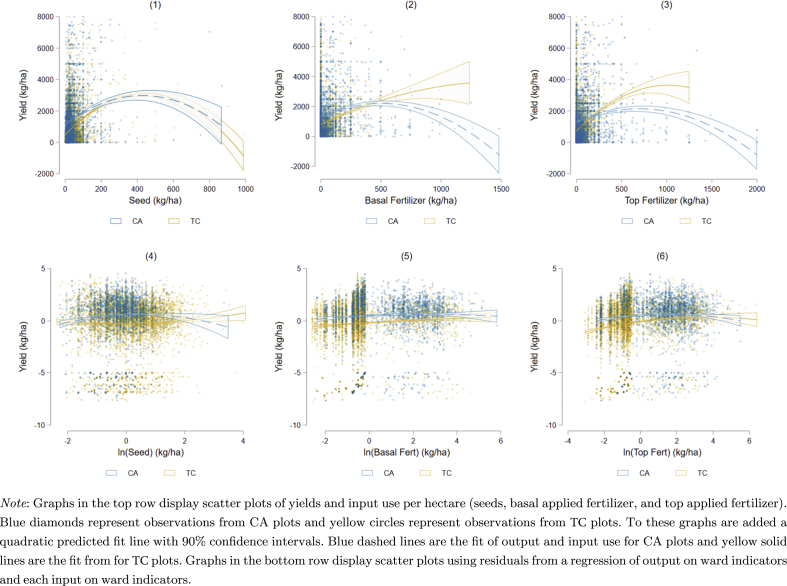
Yield response to inputs by CA adoption.